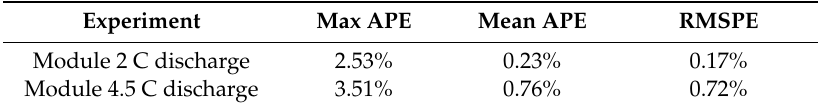
Figure 3. Module ( a ) voltage validation response ( b ) 1C charge/2.5C discharge profile ( c ) developed error and ( d ) voltage validation response ( e ) 4C discharge profile ( f ) developed error. Table 2. Battery module validation results Table 2. Battery module validation results summary.